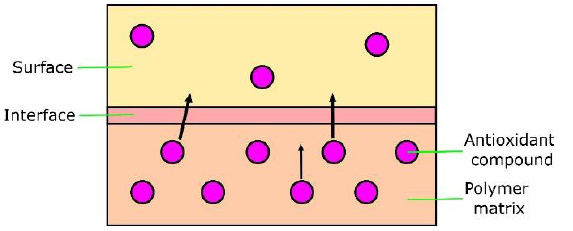
Figure 9. Scheme presenting possible migration of antioxidants onto the polymer surface.